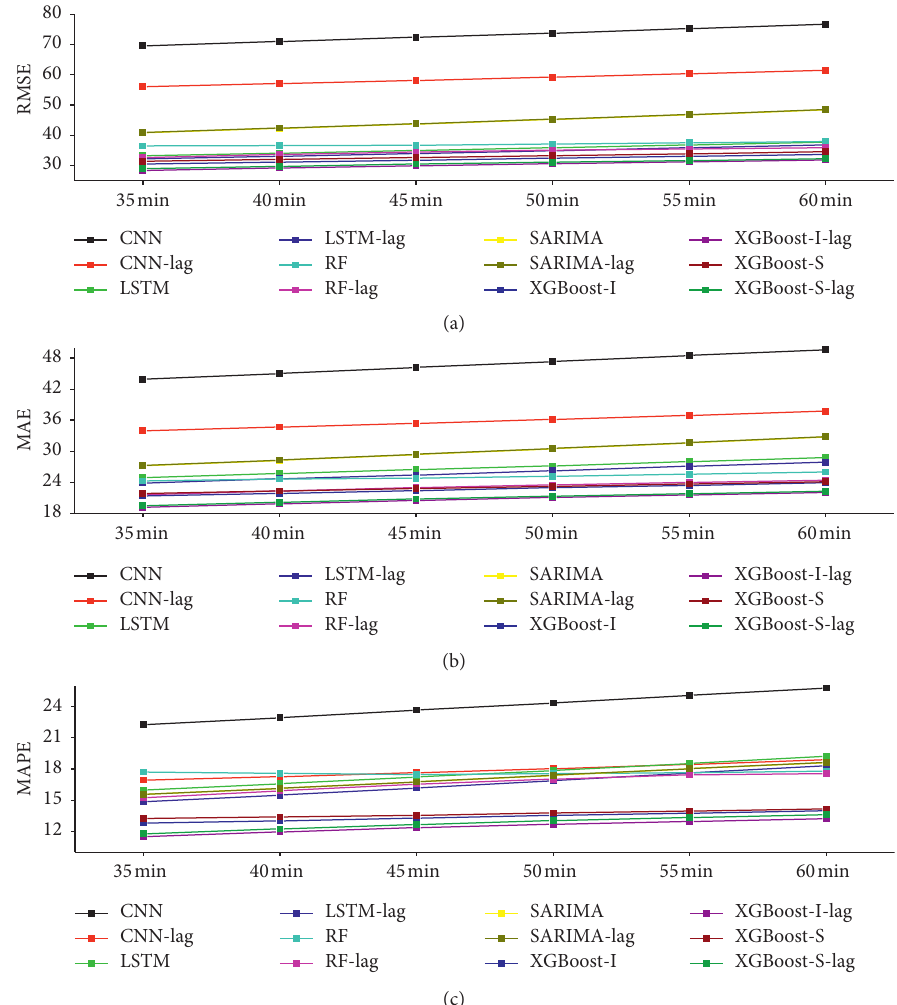
Figure 17: Comparison of traffic prediction performance of different methods in long-term 5-minute time steps of mean RMSE, MAE, and